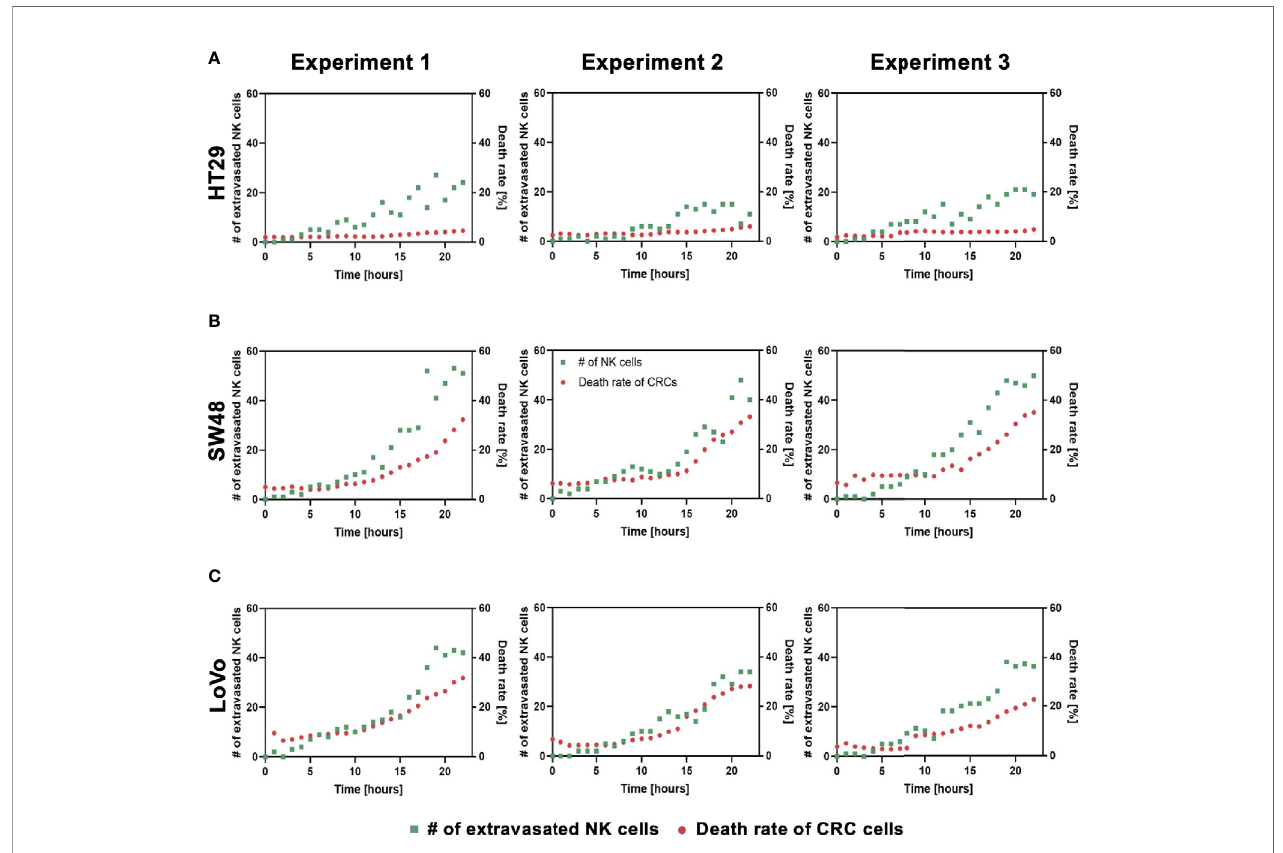
FIGURE 6 | Interactions between NK cell extravasation and their cytotoxic effects. (A) The number of NK cell extravasation (green) plotted with the number of cancer cells killed by NK cells (red) over time. The death rate of CRC cells showed no signi fi cant changes in HT29 (CMS3). (B) SW48 and (C) LoVo showed exponential increases in both the number of extravasated NK cells and the death rate of CRC cells. (n = 3 for each CRC cell